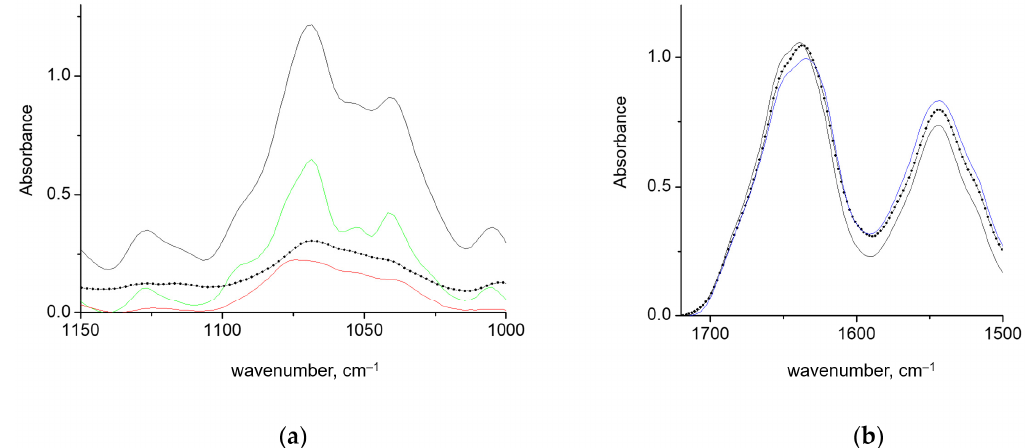
Figure 4. The absorbance spectra of κ‐ carrageenan in the conformation of helix (green) and coil (red) and the spectra of a GAPDH– κ‐ carrageenan gels at mixing at 25 °C (dotted black) and 40 °C (solid black) in the region of polysaccharide absorbance (a). The spectra of GAPDH solution (blue) and the spectra of a GAPDH– κ‐ carrageenan gels at mixing at 25 °C (dotted black) and 40 °C (solid black) in the region of Amide I and Amide II (b).